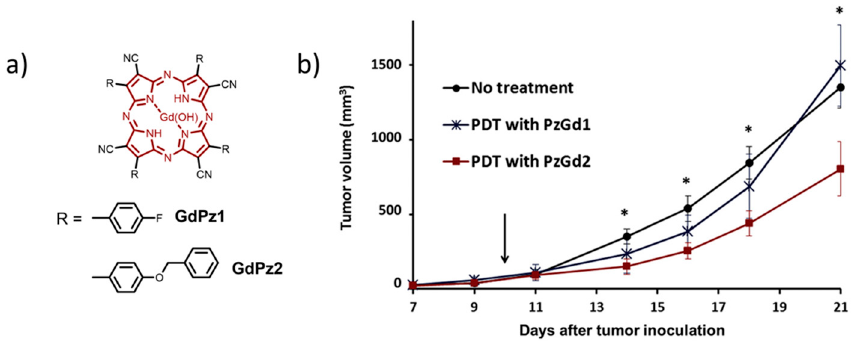
Figure 3. ( a ) Molecular structure of GdPz1 and GdPz2; ( b ) tumor volume variation as a function of time. Intravenous injection of the theranostic agent and photodynamic therapy (PDT) treatment three hours after this injection were realized on day 10 after tumor inoculation. Adapted with permission from [48]. Copyright 2017 Elsevier.